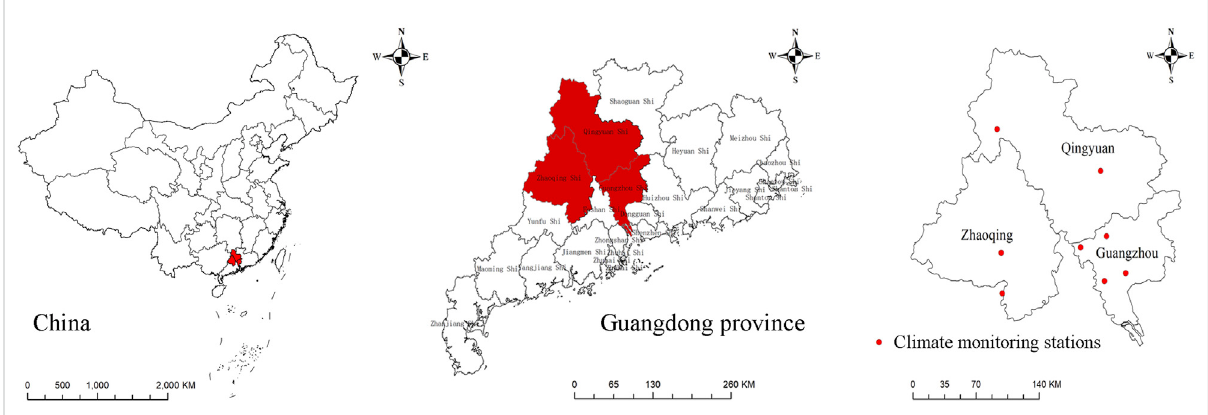
FIGURE 1 The geographic location of the central study area (in red) of Guangdong Province in China and the climate monitoring